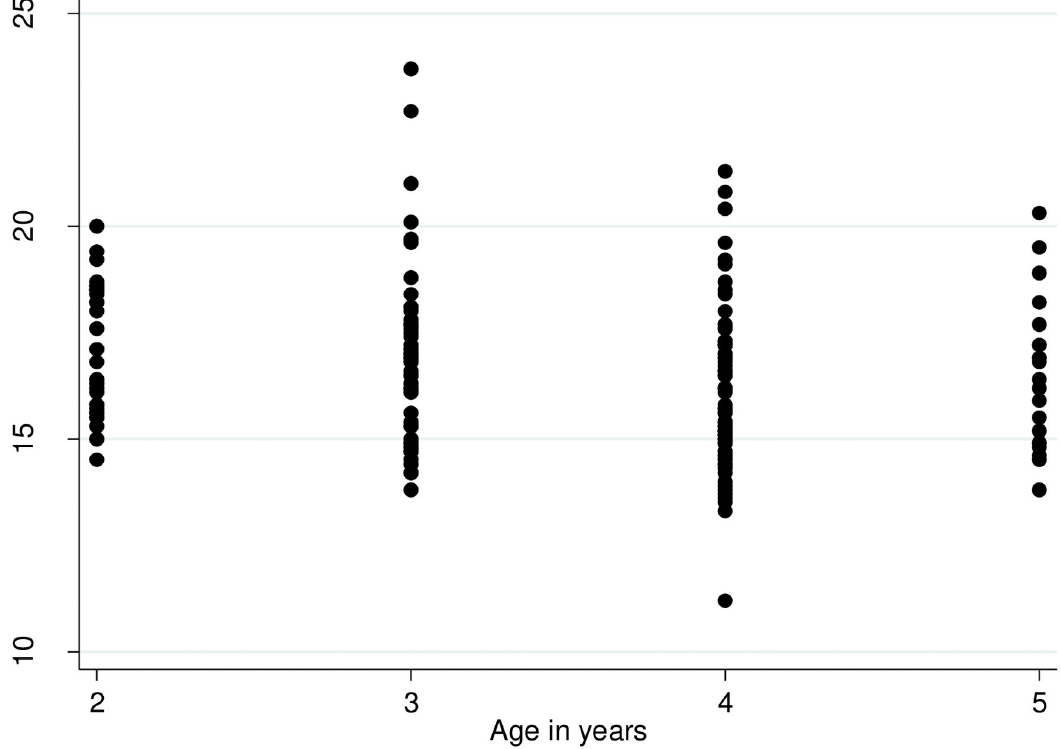
Fig 1. Changes in child BMI increase in age in years for the 197 child participants. This shows child BMI by age to visually describe how the BMI varied among participants.